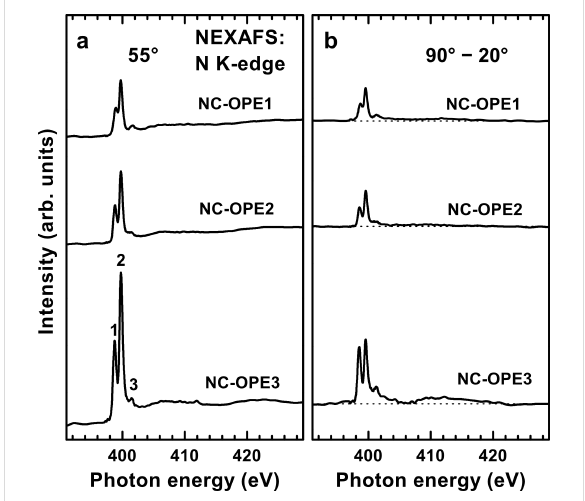
Figure 5: (a) N K-edge NEXAFS spectra of the NC-OPE n SAMs acquired at an X-ray incidence angle of 55°. (b) Difference between the N K-edge spectra acquired at X-ray incidence angles of 90° and 20°. The zero level of the difference spectra is shown by dotted lines. The most prominent absorption resonances are marked by numbers; see text for details.